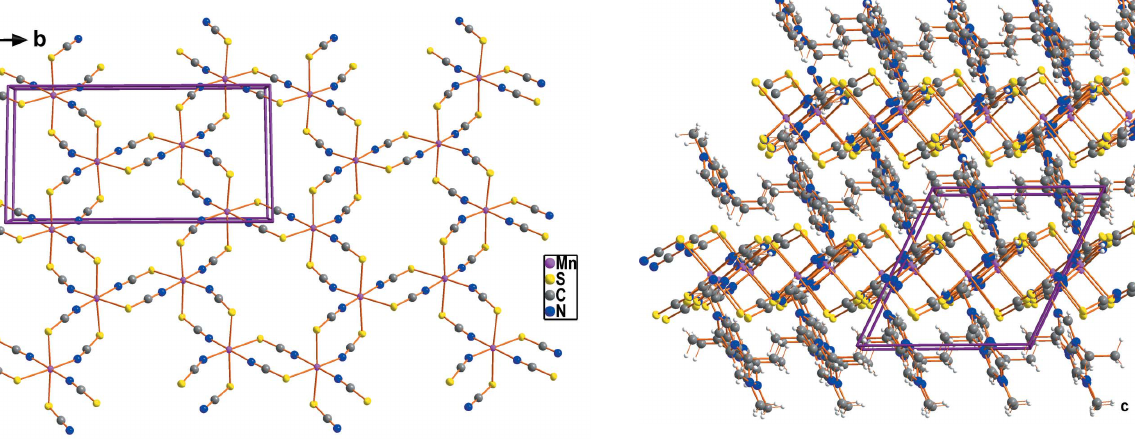
Figure 2 View of the structure of the anionic [Mn(NCS) 3 ] (cid:2) layer.